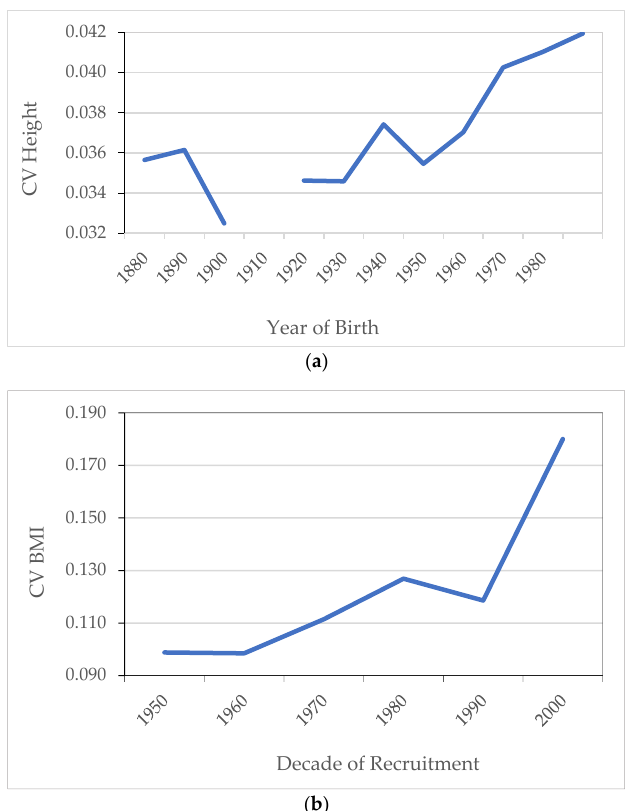
Figure 9. ( a ) Height coefficient of variation by decade of birth. ( b ) BMI coefficient of variation by decade of birth. Source: AMSB, ACDS. Own work.